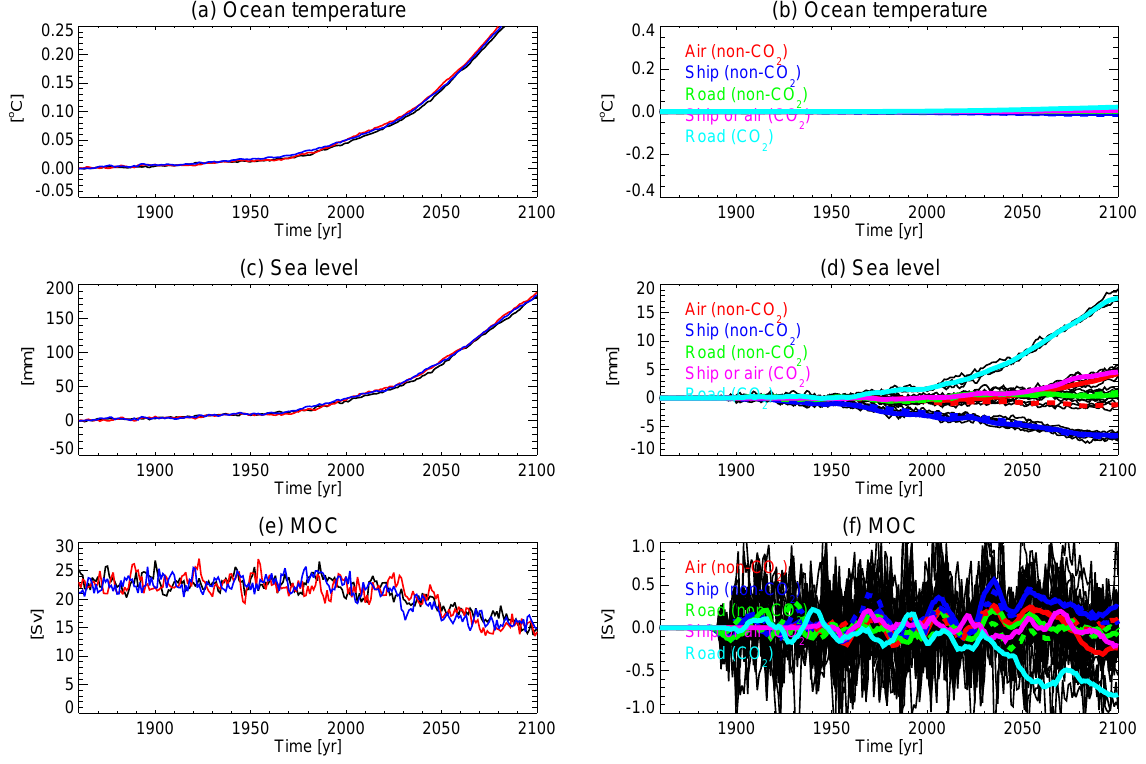
Fig. 20. Left: time series of total anthropogenic impact on (a) the ocean mean temperature, (c) sea level and (e) meridional overturning circulation. The three different lines (black, red and blue) represent the three different members of the ensemble. Right: the impact by road transport, shipping and aviation, separately for their CO 2 , non-CO 2 and non-CO 2 * impact (the non-CO 2 * impact is indicated by the dashed lines) on (b) the ocean mean temperature, (d) sea level and (f) meridional overturning circulation. The thin black lines indicate the individual impact from each of the three members of the simulation, and the thick lines indicate the 11-yr running average of the ensemble mean.